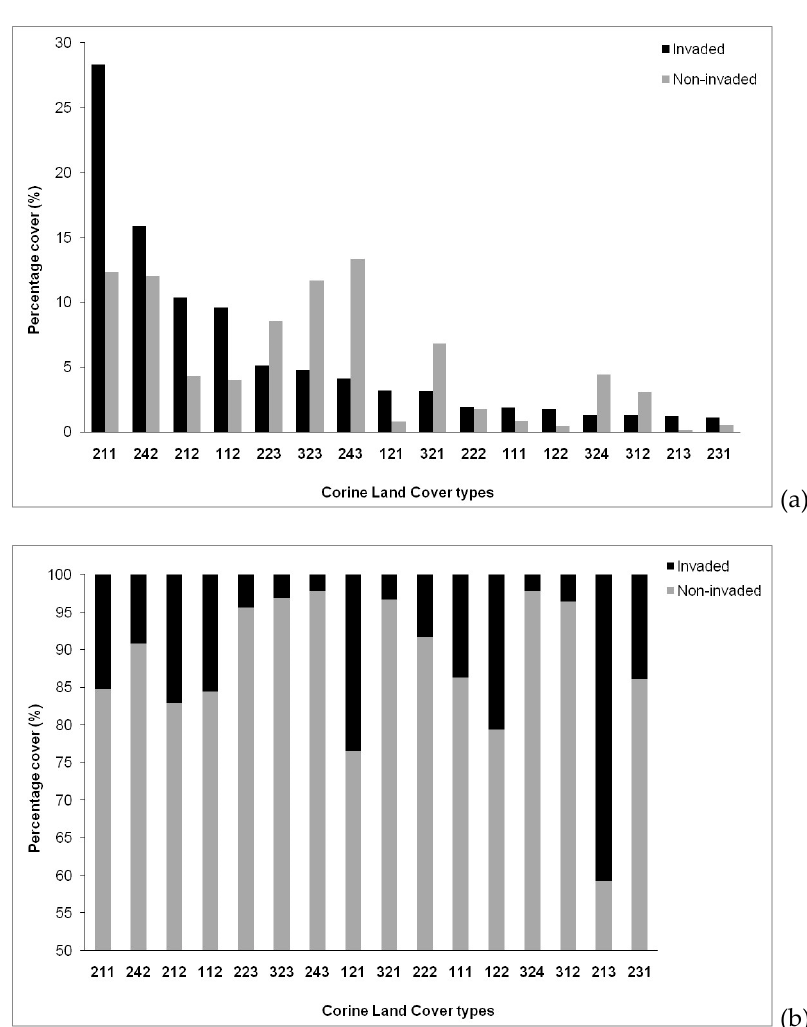
Figure 4. Percentage cover (%) among the various Corine Land Cover types (CLCTs) ( a ) and percentage cover (%) of each Corine Land Cover type ( b ) in the noninvaded areas (grey color) and the invaded areas (black) by Solanum elaeagnifolium in Greece. Agricultural CLCTs—211: Non-irrigated arable land; 242: Complex cultivation; 212: Permanently irrigated land; 223: Olive groves; 243: Land principally occupied by agriculture with significant areas of natural vegetation; 222: Fruit trees and berry plantations; 213: Rice fields; 231: Pastures. Forests and semi-natural CLCTs—323: Sclerophyllous vegetation; 321: Natural grassland vegetation association; 324: Transitional woodland shrub; 312: Coniferous forest; 321: Natural grassland vegetation association; 323: Sclerophyllous vegetation; 324: Transitional woodland shrub. Artificial CLCTs—112: Discontinuous urban fabric; 121: Industrial or commercial units’ surfaces; 111: Continuous urban fabric; 122: Road and rail networks and associated land. Land-use types covering less than 1% of the total invaded area are not